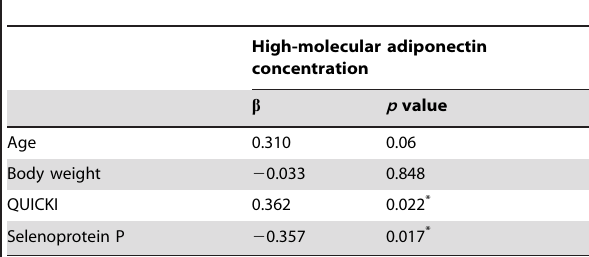
Table 5. Multivariate regression analysis of high-molecular adiponectin concentration as a dependent variable.